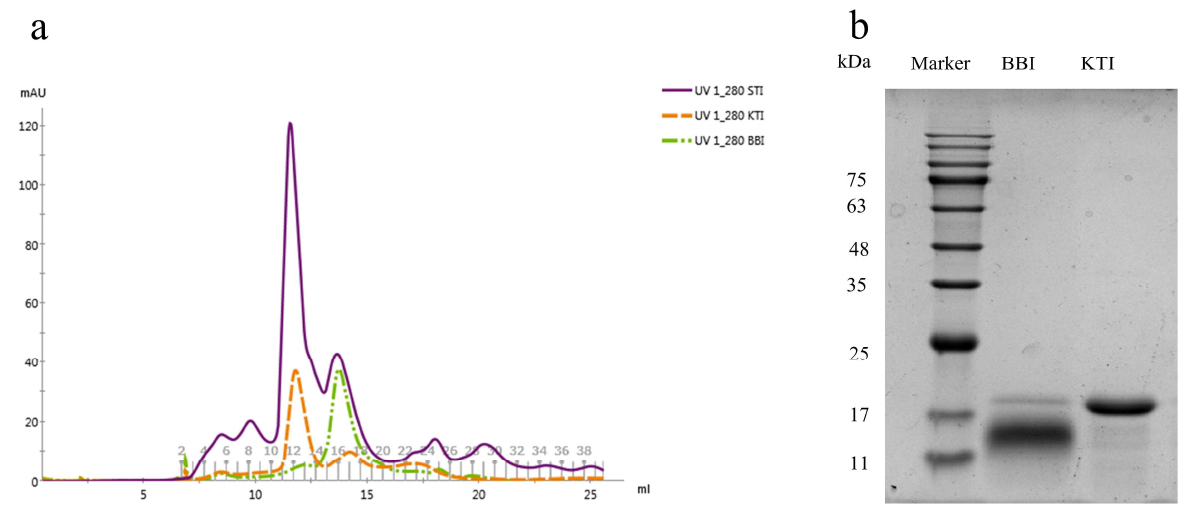
Figure 4. The effect of gel filtration chromatography on STI isolation and purification ( a ). The electrophoretic pattern of the protein isolated from STI ( b ).